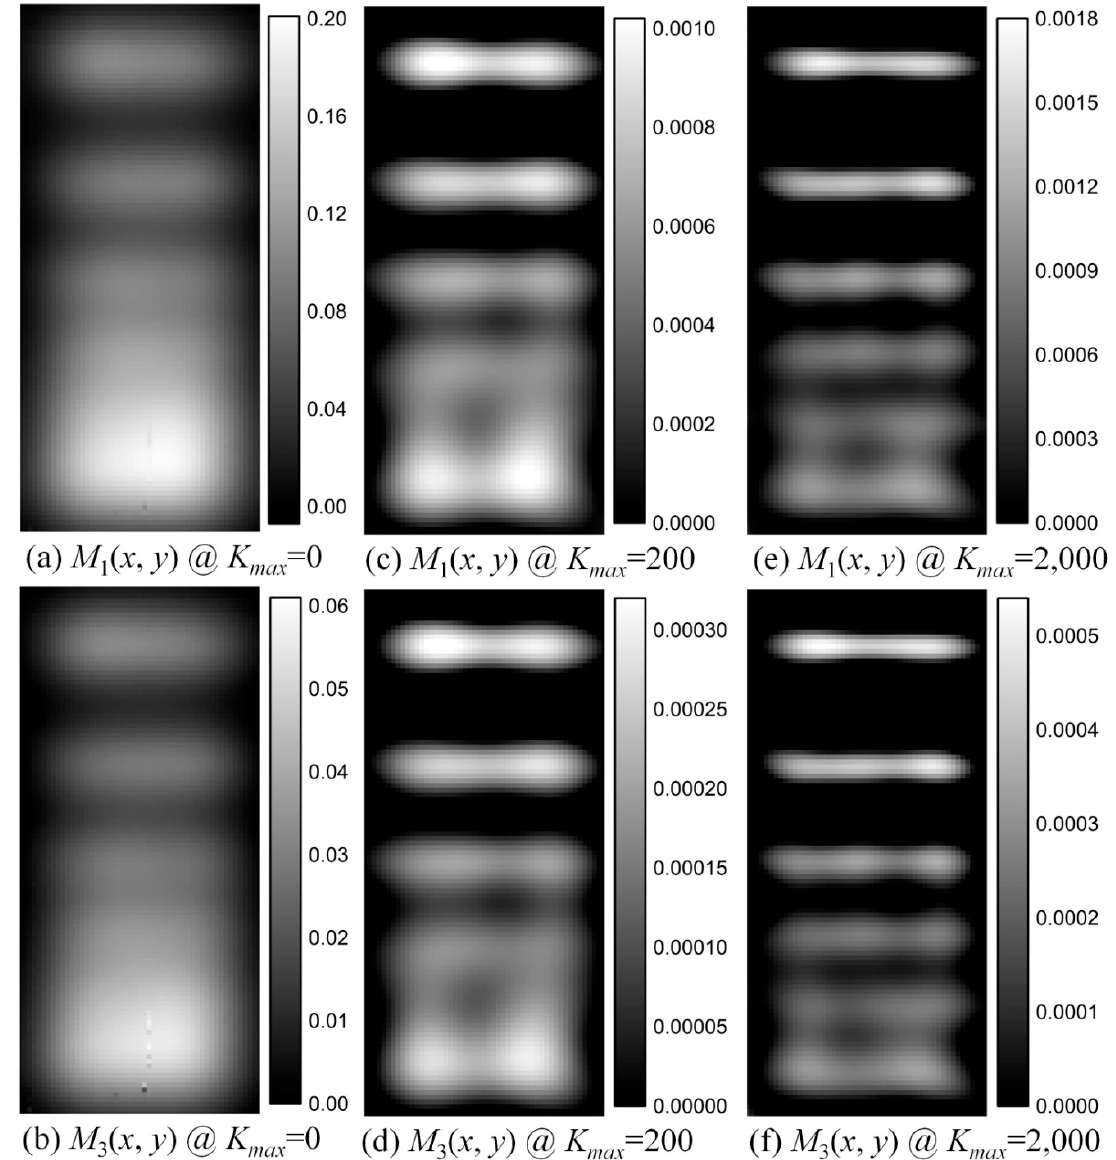
Figure 3. ( a ), ( c ) and ( e ) show the measured and deconvolved spatial distributions of the 1st Figure 3. ( a , c , e ) show the measured and deconvolved spatial distributions of the 1st harmonics for harmonics for K max = 0, 200 and 2000, respectively. ( b ), ( d ) and ( f ) show the measured and K max = 0, 200 and 2000, respectively. ( b , d , f ) show the measured and deconvolved spatial distributions deconvolved spatial distributions of the 3rd harmonics for K max = 0, 200 and 2000, respectively. The of the 3rd harmonics for K max = 0, 200 and 2000, respectively. The scanning FOV is 10 mm × 22 mm scanning FOV is 10 mm × 22 mm with a scanning step of 0.2 mm. The images of the 1st and 3rd with a scanning step of 0.2 mm. The images of the 1st and 3rd harmonics for K max = 0 represent measured (undeconvolved) harmonics for K max = 0 represent measured (undeconvolved) ones.